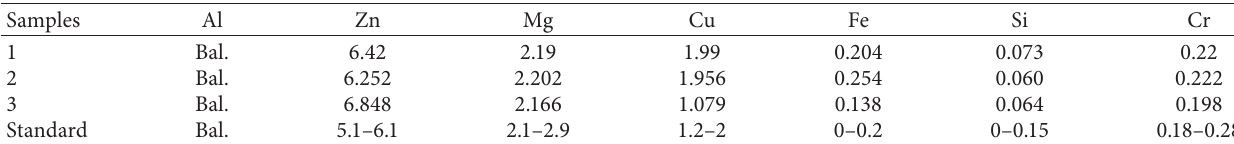
Table 2: Chemical composition of specimens